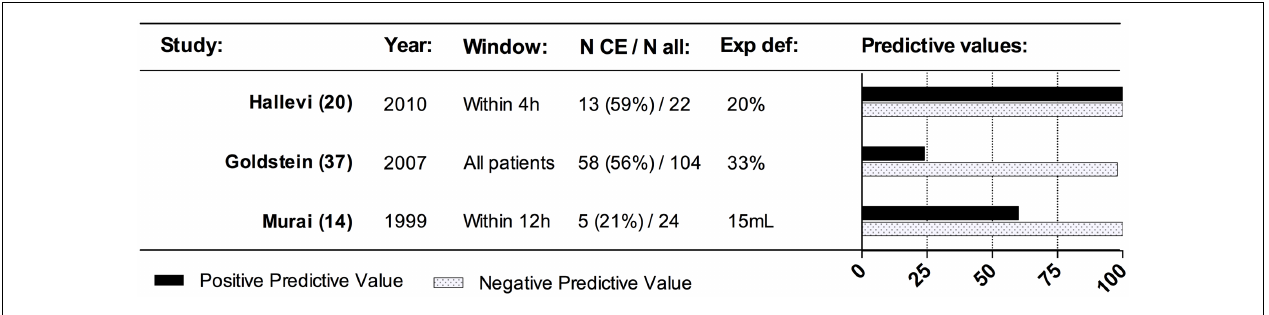
not the effect of contrast extravasation in addition to spot sign – please see text. N CE, number of patients with contrast extravasation; N all, total number of patients in the population; exp def, definition of hematoma expansion.